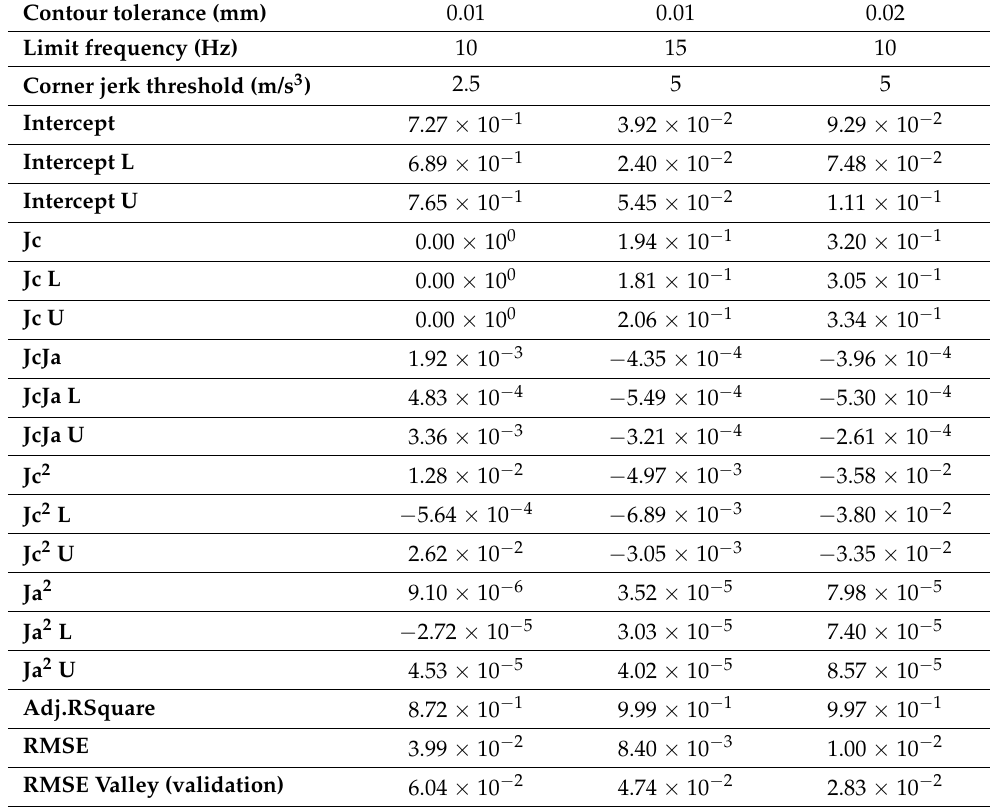
Table A1. Parameters of the multiregression models describing the dependence of the TV coefficient on the corner jerk limit (denoted by J c ) and the axis jerk limit (denoted by J a ). Results for combinations of low contour tolerance and low limit frequency. Postfixes L and U denote the lower and upper limits of the 95% confidence intervals, respectively.